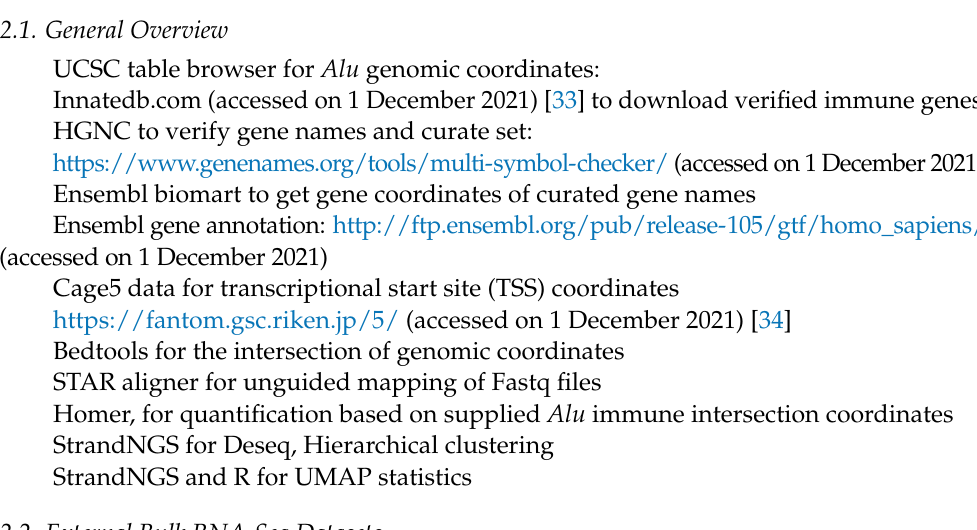
Figure 1. Overview of Alu elements versus gene coordinate definition and intersection.